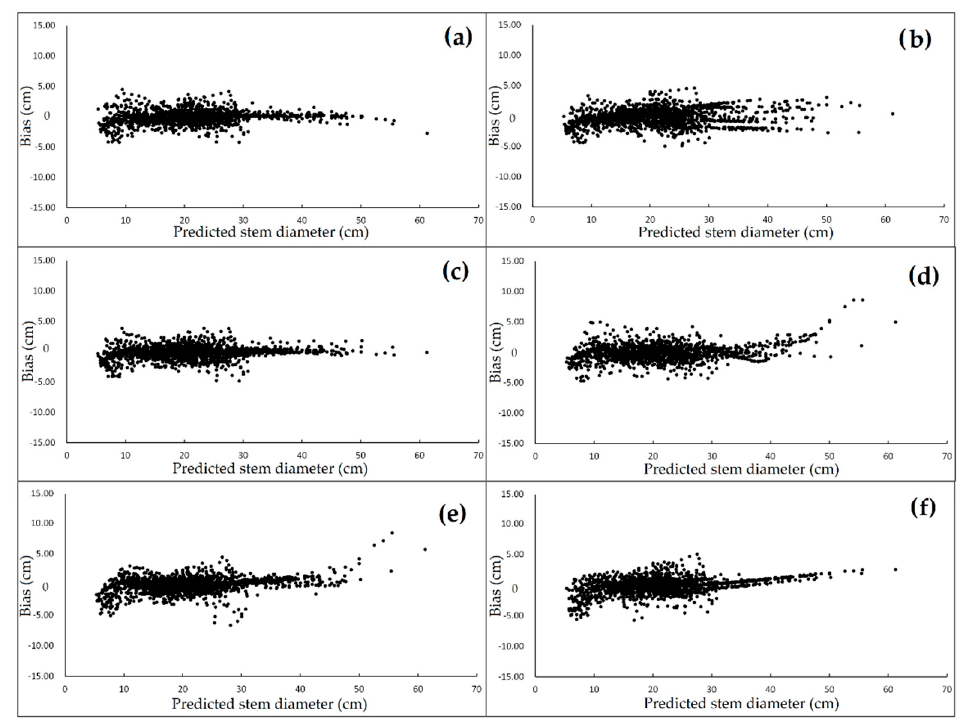
Figure 4. Residual distributions of the models ( a ) Kozak 2004, ( b ) Fang 2000, ( c ) ANN, ( d ) GPR, ( e ) CatBoost, ( f ) GP.